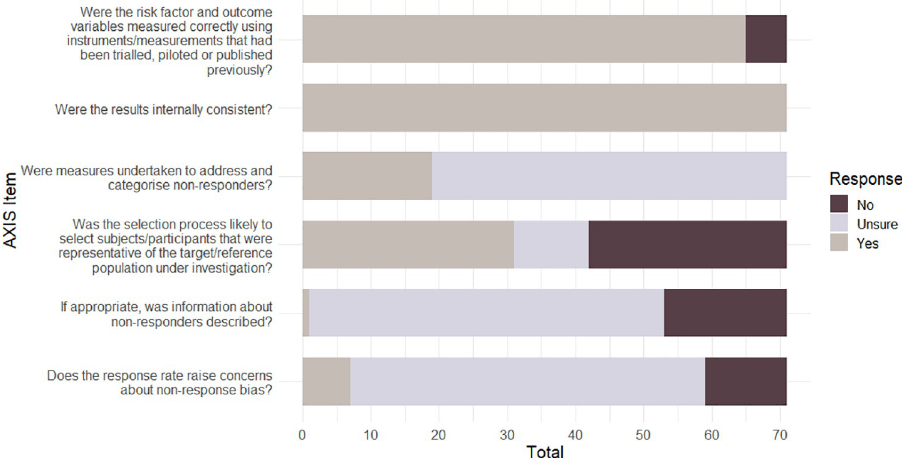
Fig 4. AXIS possible biases summary for the 71 papers included in the review.